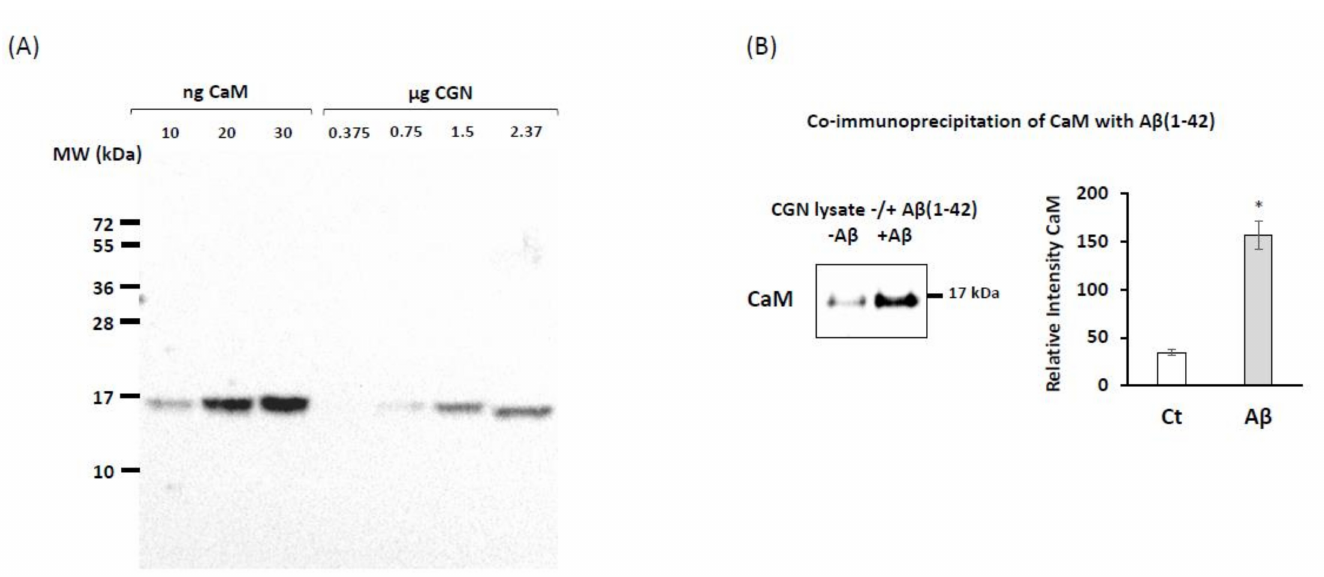
Figure 1. Co-immunoprecipitation between calmodulin (CaM) and A β (1–42). ( A ) Quantification of calmodulin content in cere- bellar granule neurons (CGN) lysates. ( B ) Western blotting of CaM (anti-CaM 1716-1, Epitomics) after co-immunoprecipitation assay with mouse anti- β -amyloid antibody (Sigma, A8354), as described in the Materials and Methods